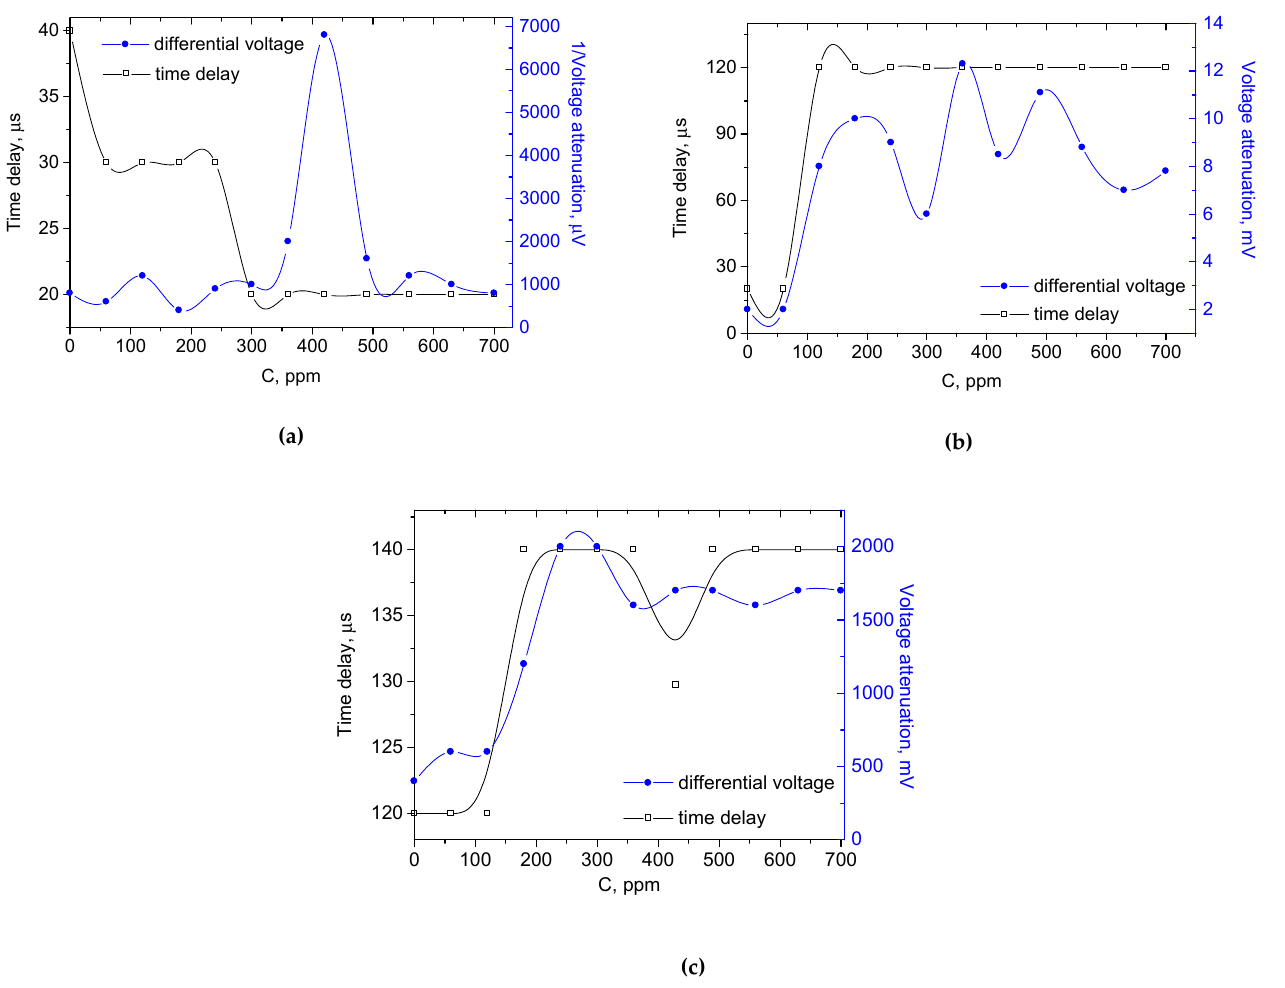
Figure 6. Voltage differences between the output and input signals of the SAW and time delay of the signal vs. ethanol concentration: ( a ) device 1, ( b ) device 2, and ( c ) device 3.